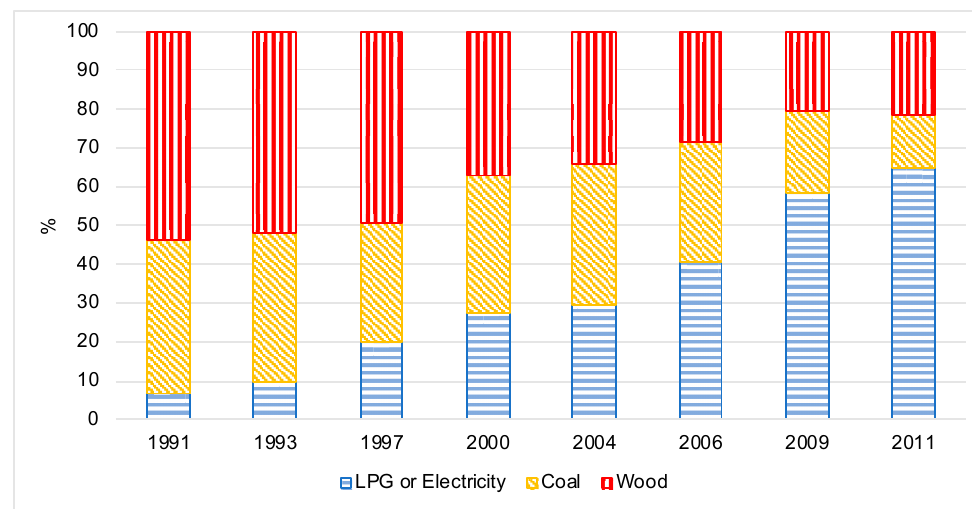
Figure 1. Cooking fuel use across survey years among nonpregnant women aged 18 to <80 years living in rural areas of China (n = 22,118 observations from n = 6671 women, median observations per woman 3). Table 1. Characteristics according to cooking fuel category (n = 22,118 observations from n = 6671 women, median observations per woman 3).